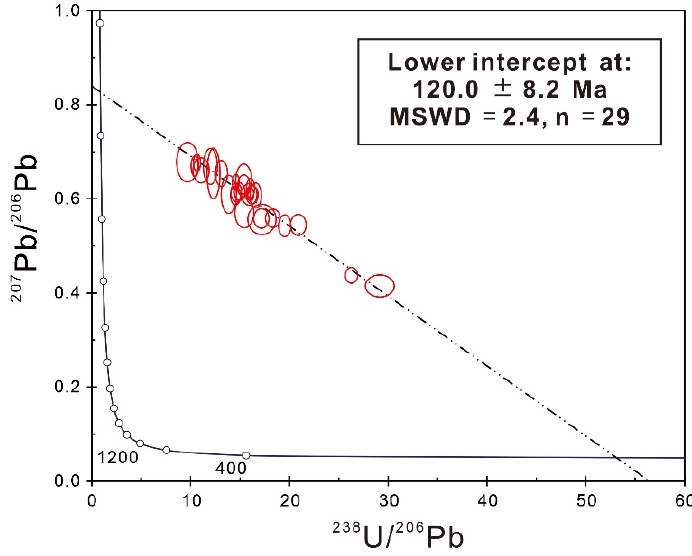
Figure 4. Sphene U‑Pb lower intercept ages of the hornblende diorite (21LBS27) from the Long‑ Figure 4. Sphene U-Pb lower intercept ages of the hornblende diorite (21LBS27) from the Long- baoshan alkaline complex. baoshan alkaline complex. Table 1. LA‑ICP‑MS sphene U‑Pb isotope data of hornblende